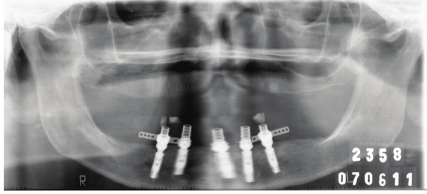
Figure 14: Panoramic radiography after 7 days of the prosthesis installation.